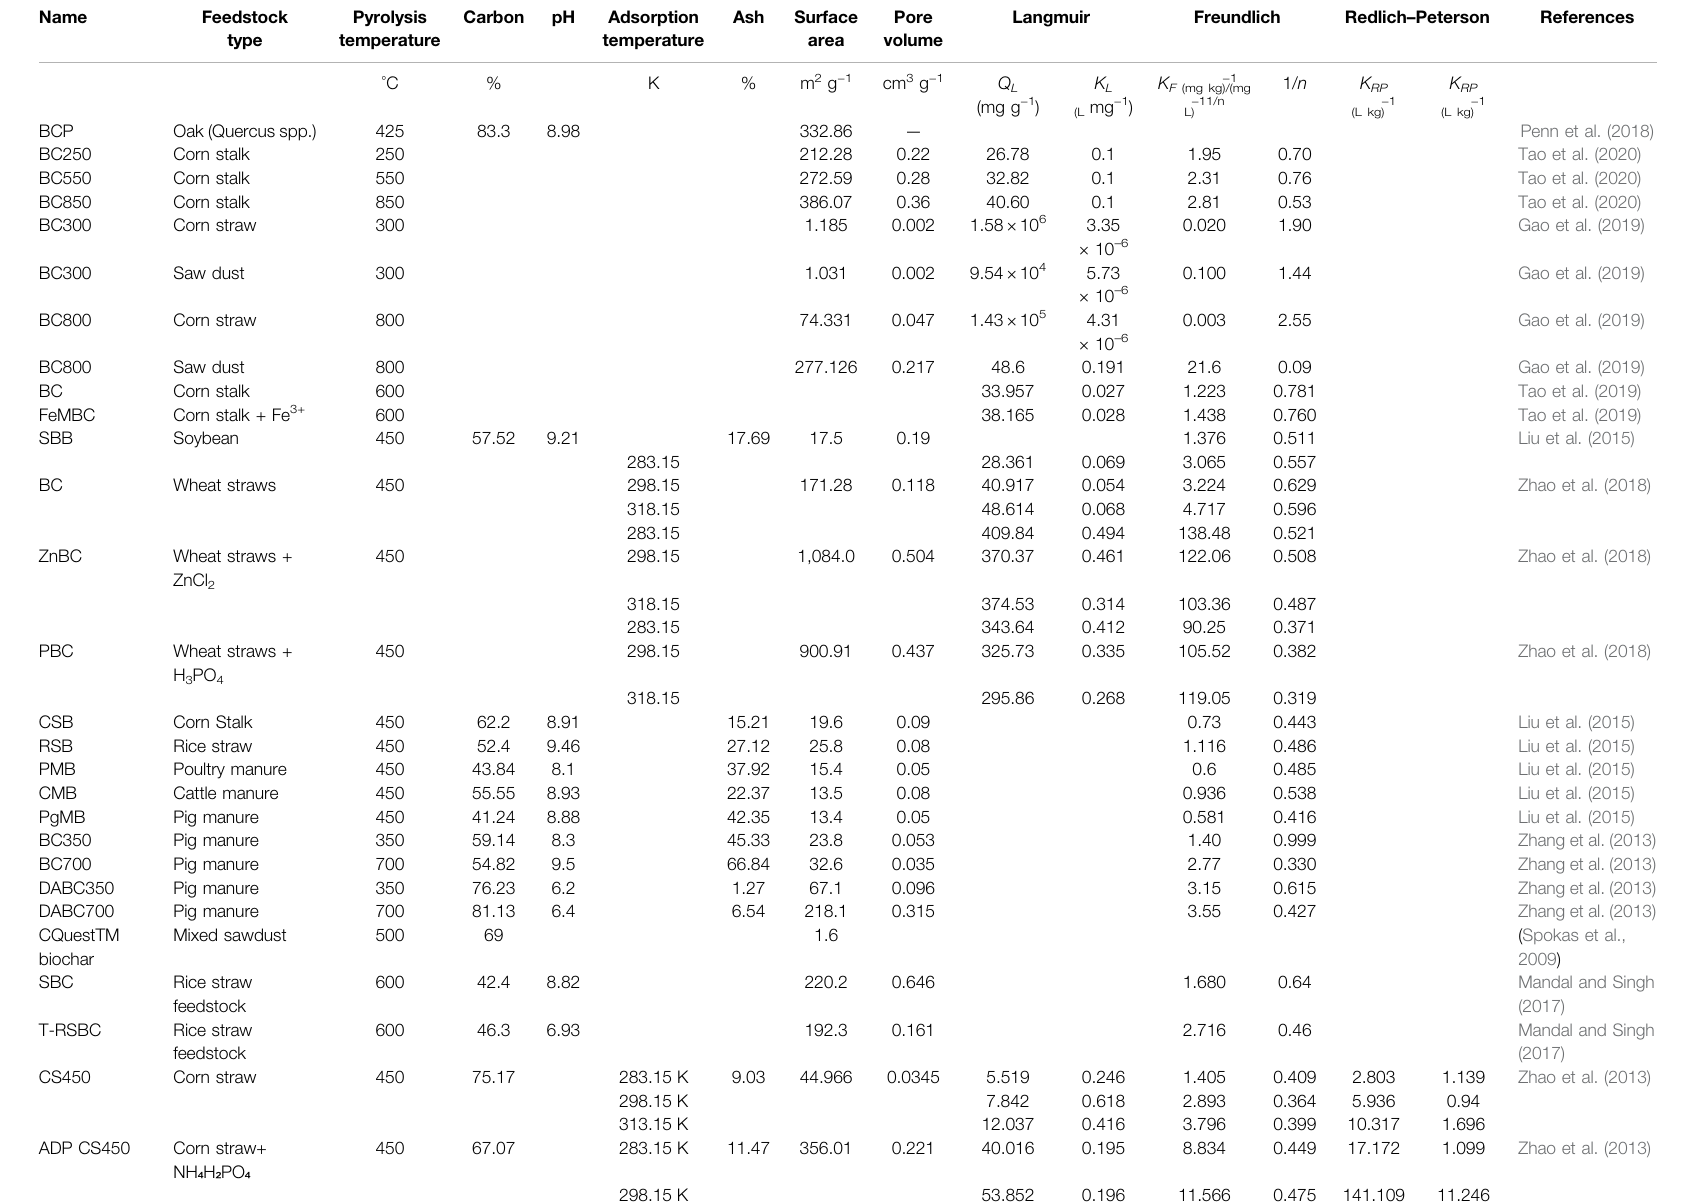
TABLE 2 | Ef fi ciency of various biochars for the removal of atrazine from aqueous media as predicted by Langmuir, Freundlich, and Dubinin – Radushkevich